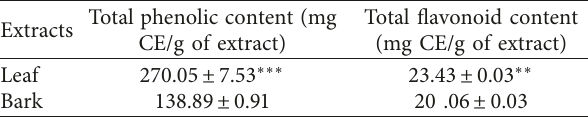
Data are expressed as mean ± SD, n � 3; significantly different at ∗∗∗ p < 0 . 001 when compared to standards (ascorbic acid in the DPPH test and catechin in the ABTS test); mg CE/g of extract: milligrams of catechin equivalent per gram of extract. † p < 0 . 001 compared to bark extract. Table 3: Total phenolic and flavonoids contents of the hydro- ethanolic leaf and bark extracts of Psychotria densinervia .